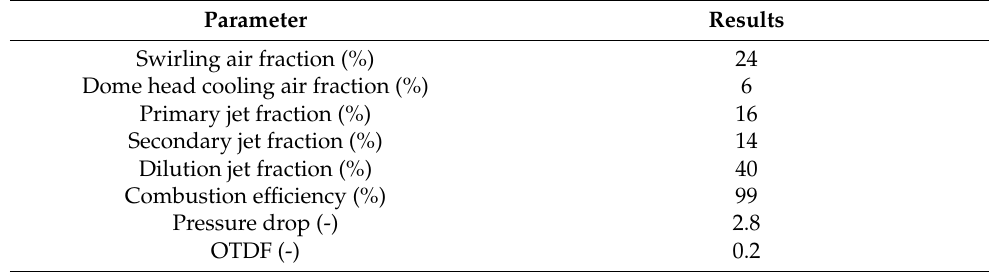
Table 3. Flow distribution and performance